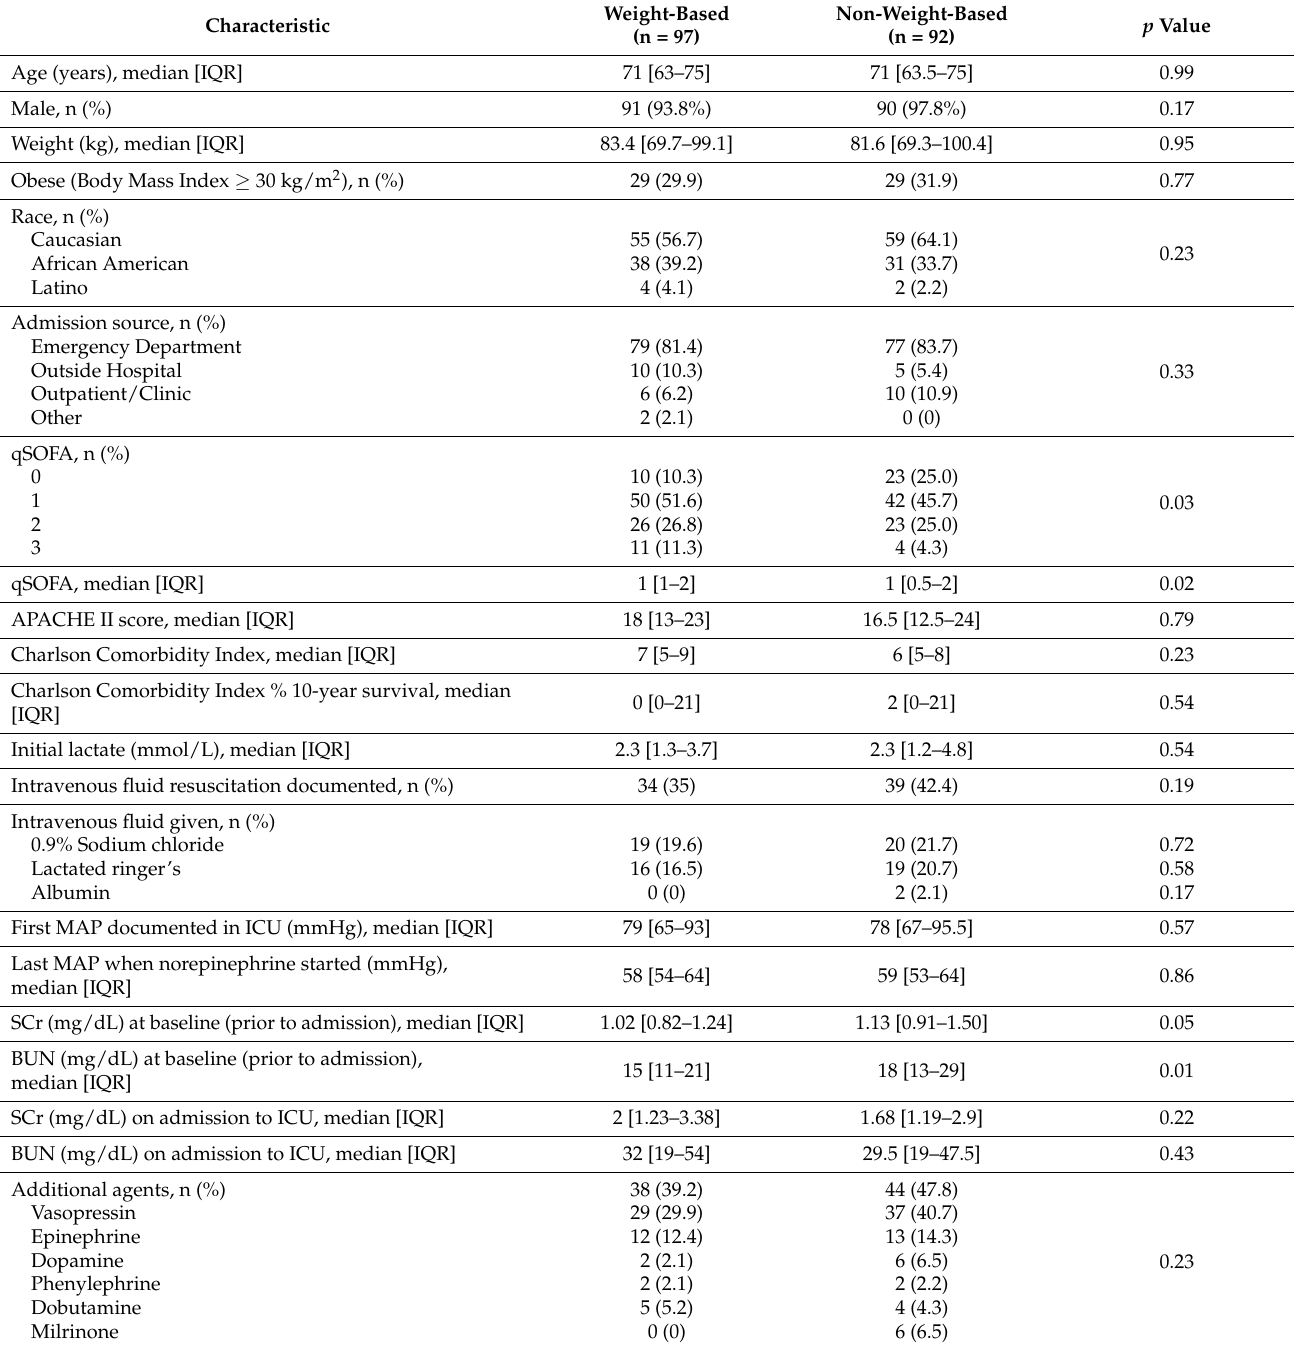
Table 1. Demographic and Baseline